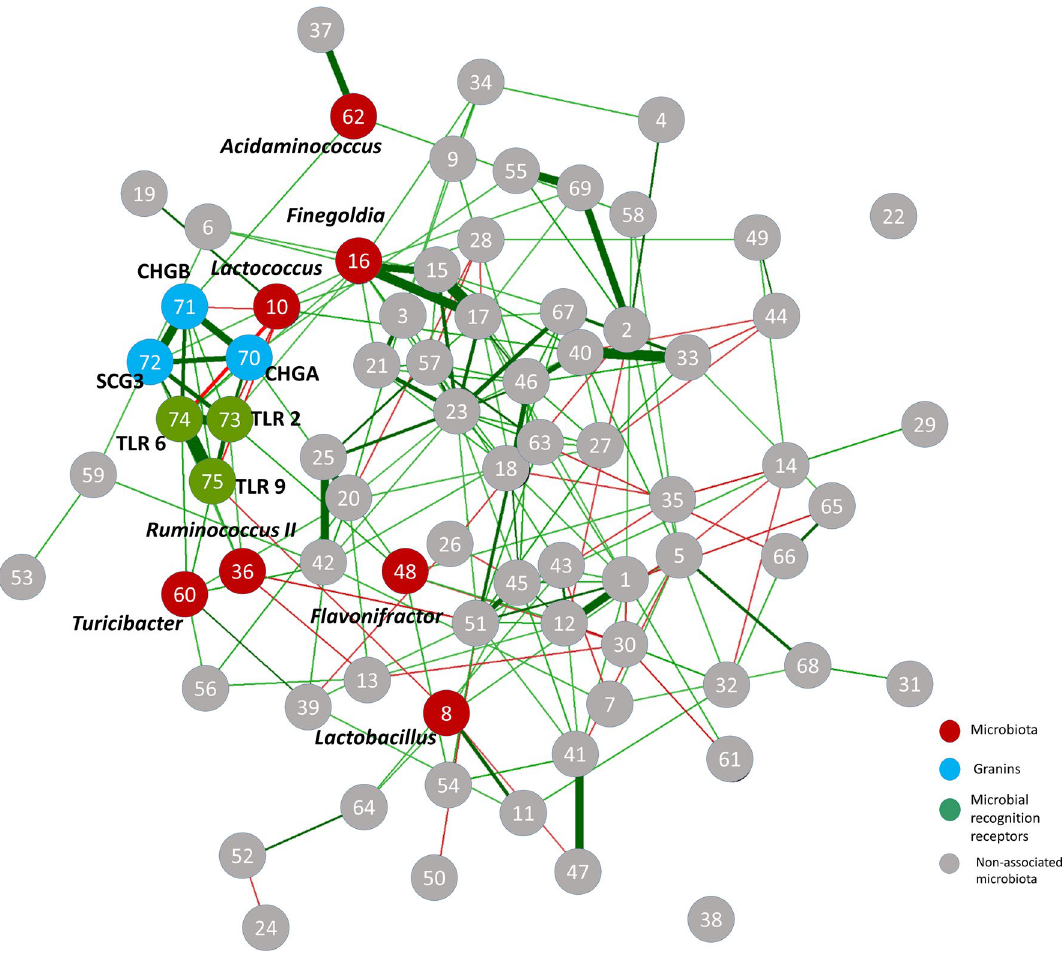
Figure 6. Detailed analysis of the immune-enteroendocrine cluster in IBS patients and microbiota on genus level. Red color highlights the bacteria significantly associated to mucosal markers, while grey marks remaining bacteria of the phylum. Only statistically significant correlations are plotted. Green edges show positive correlation, red edges negative correlation. Closer proximity of nodes and thicker edges show higher relative correlation strength. Most relevant nodes are labelled in the figure, and the legend to the grey nodes is given in